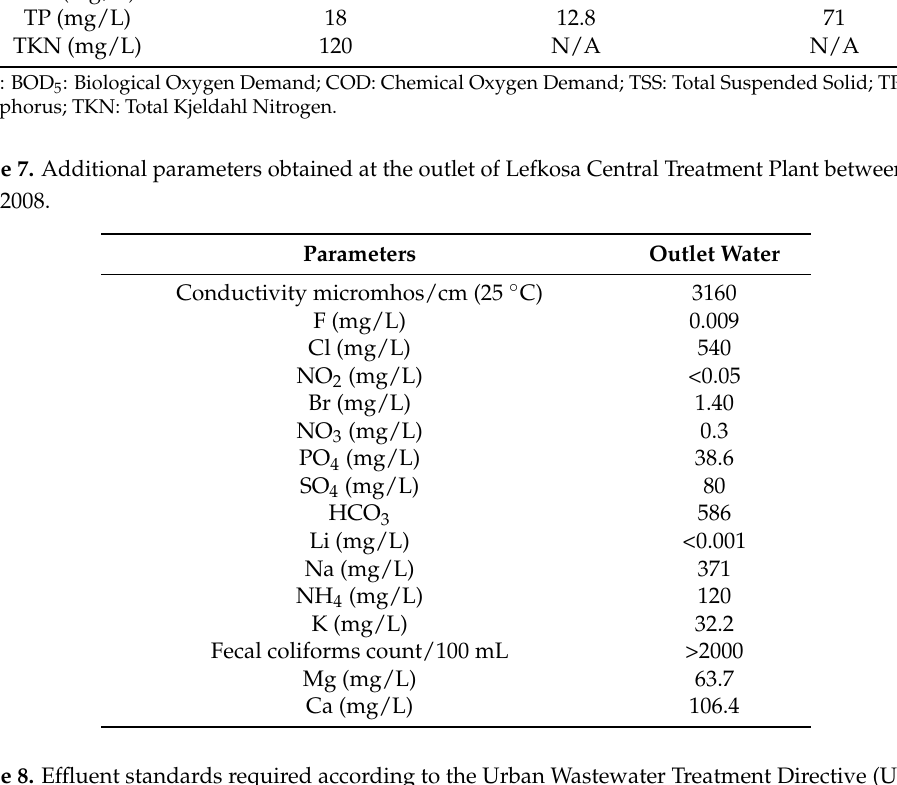
Table 8. Effluent standards required according to the Urban Wastewater Treatment Directive (UWTD) of the European Union